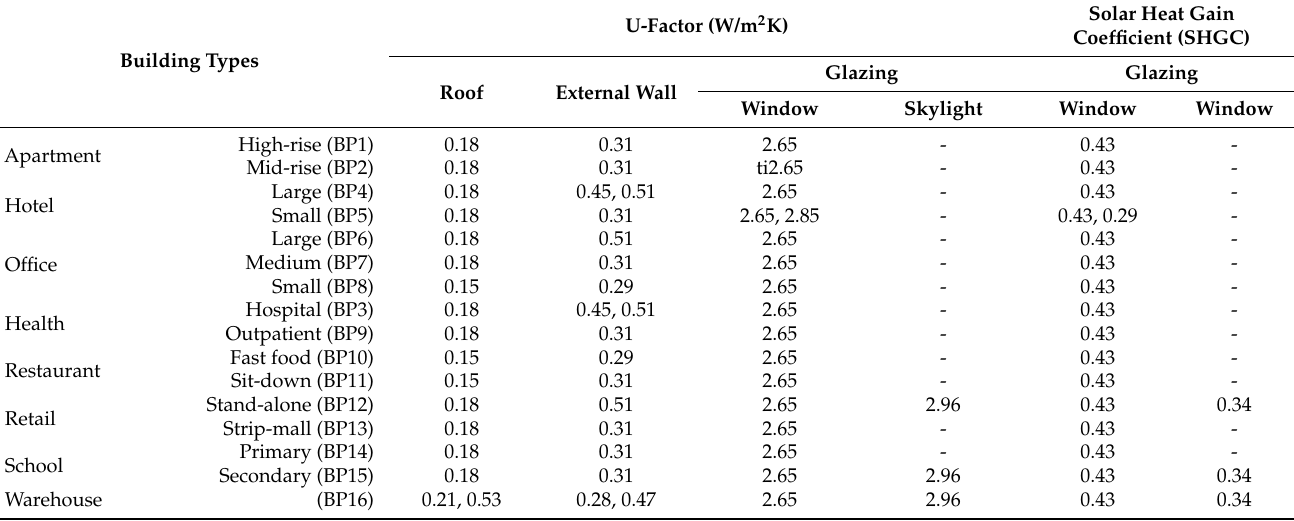
Figure 4. Building prototypes from the ASHRAE 90.1 standard [74] . Table 3. Technical description of the prototype envelope components.